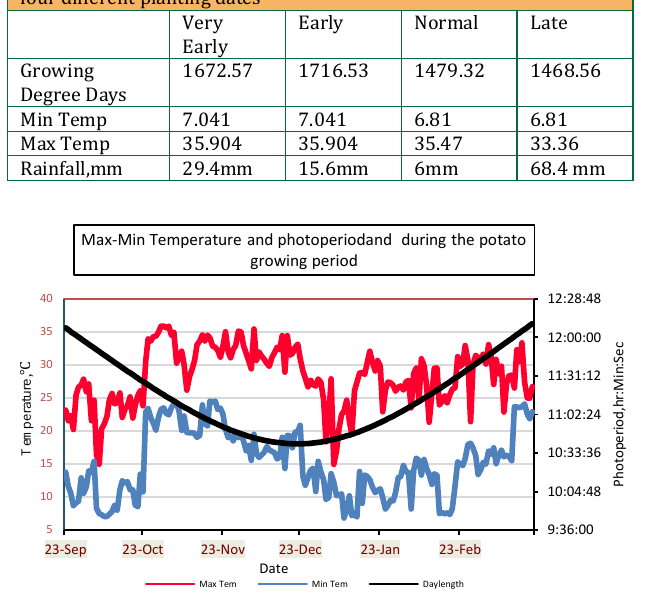
Figure 1: Max-Min Temperature and photoperiod during the potato growing period